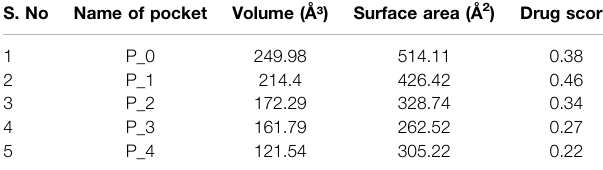
TABLE 1 | Binding site prediction granularity: Properties and druggability for